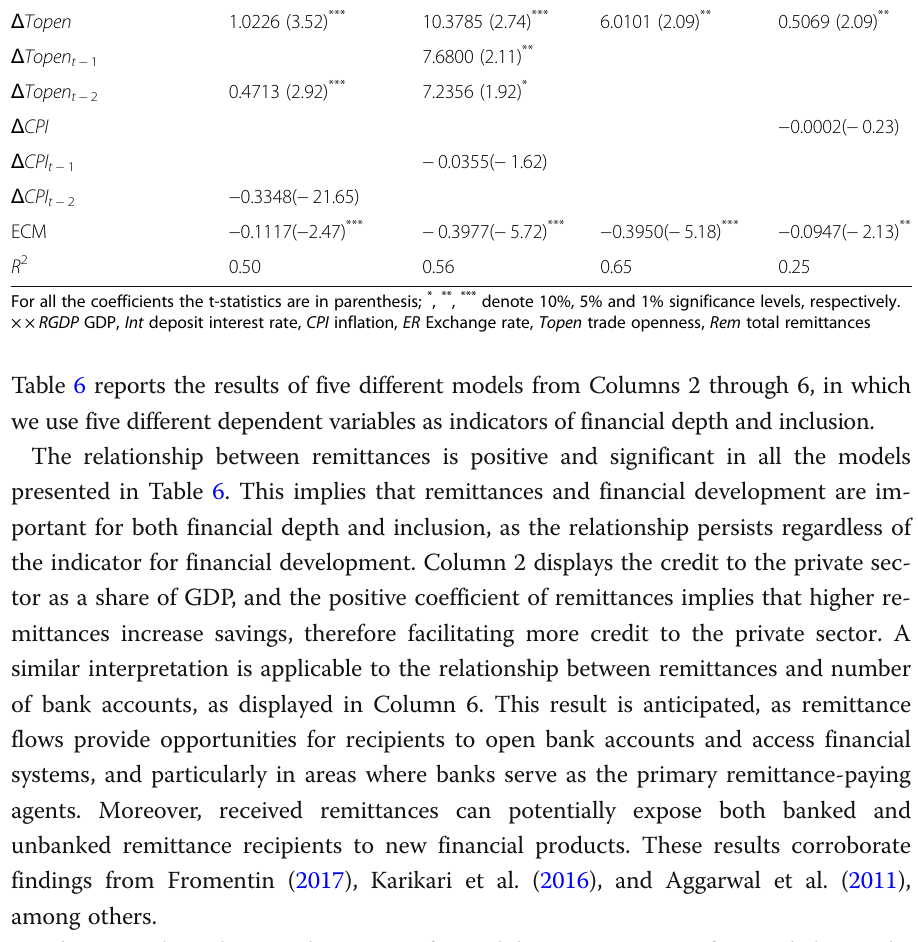
Coefficient (The dependent variable is Δ in the value of mobile transactions)